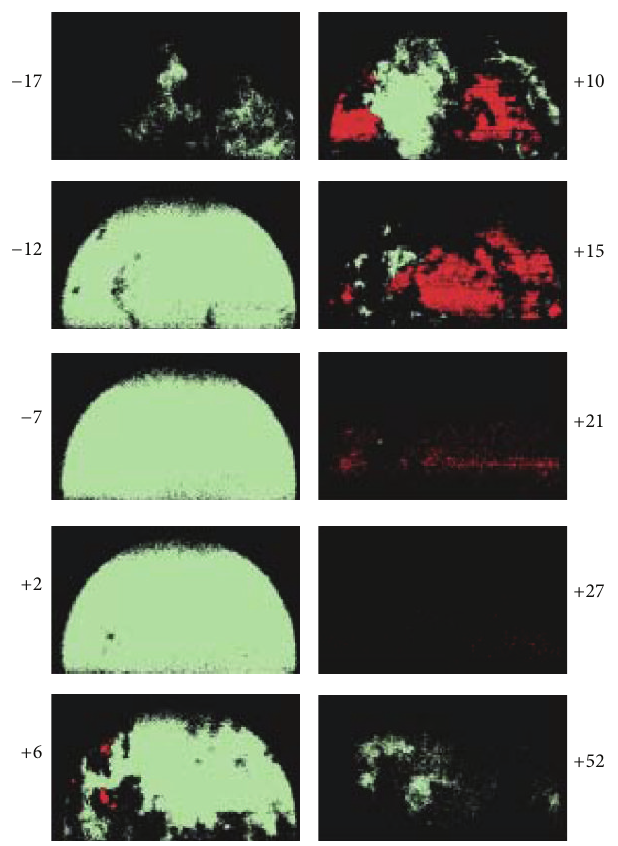
Figure 15: Single-shot images from onset of LTR combustion until the end of the main combustion. Formaldehyde is shown in green and OH is shown in red [76].